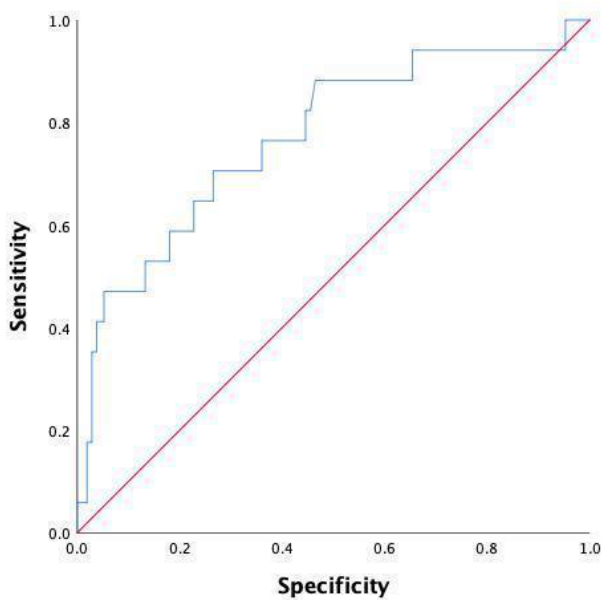
Figure 3. ROC curve of N and NLR before PSM analysis on day 5 after surgery.